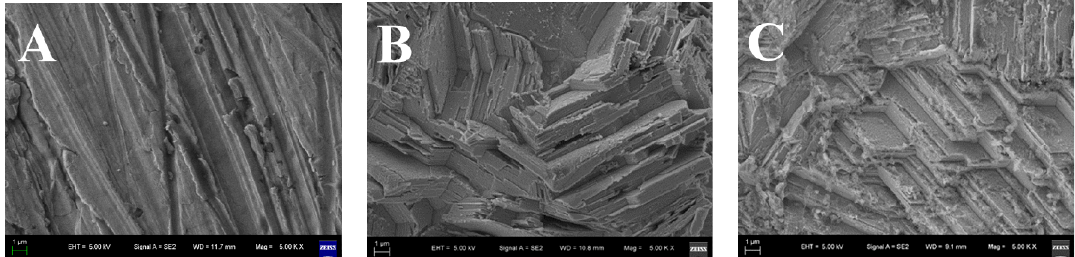
Figure 8. SEM of the zinc sheet before soaking ( A ) and after soaking 2 days ( B ) and 30 days ( C ) in the aqueous electrolyte containing 0.2 M disodium malonate.